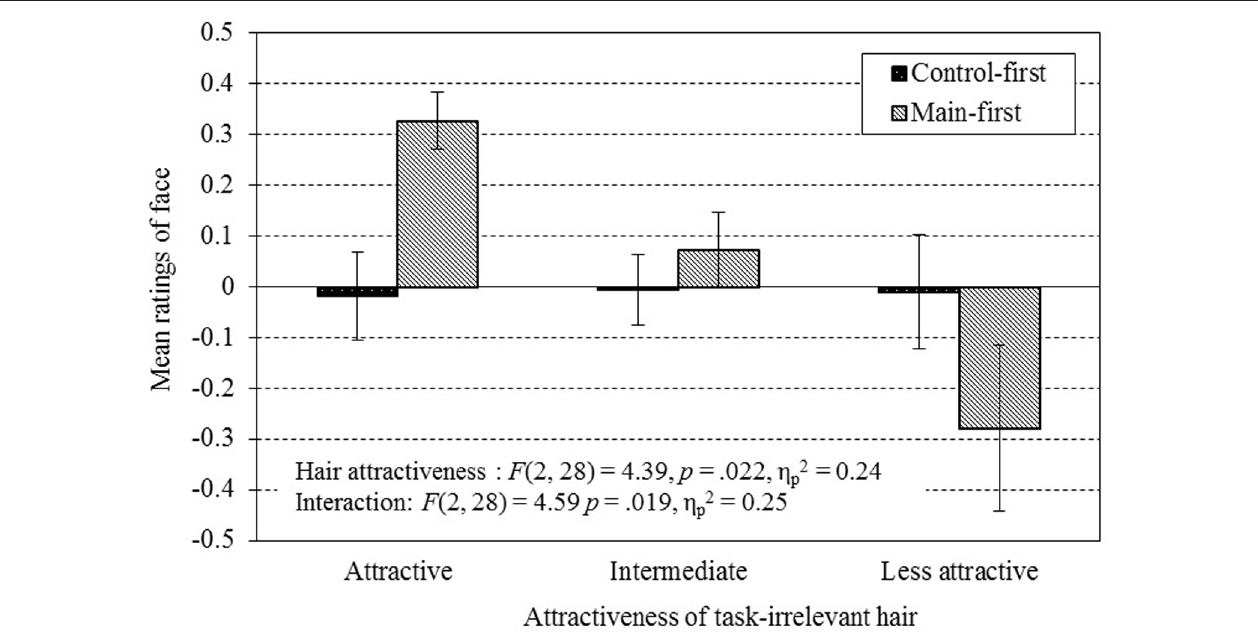
FIGURE 9 | Attractiveness ratings of face presented with task-irrelevant hair in control-first and in main-first task order. There was a significant interaction between task-order and task-irrelevant hair attractiveness